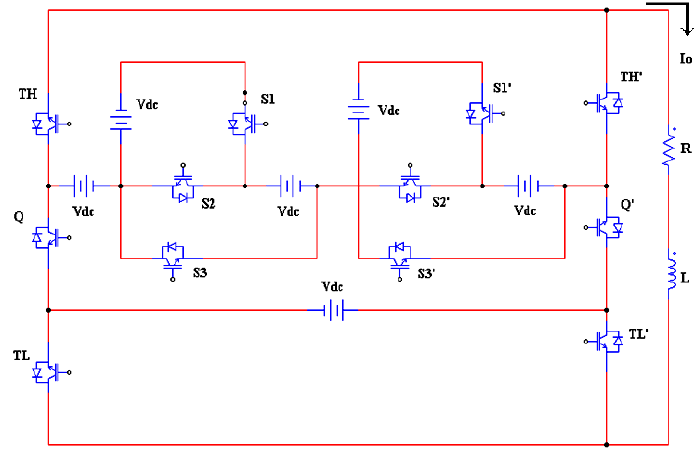
Figure 27. MLI circuit (symmetric mode).